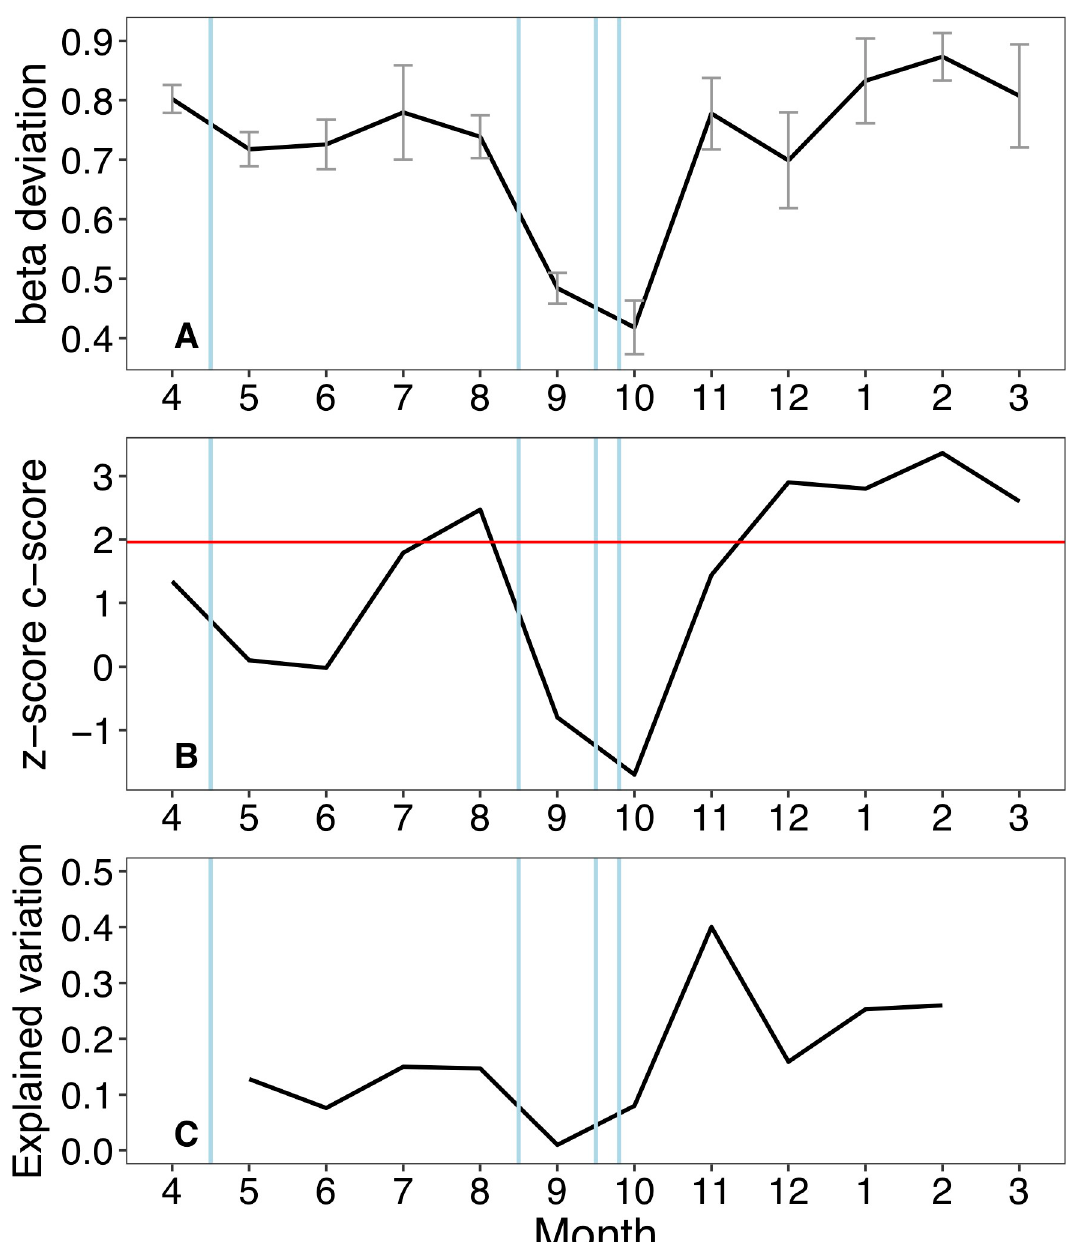
Fig 7. Inferring community assembly mechanisms. Temporal patterns in mean pairwise beta-deviation across waterbodies (A), species co-occurrence z-scores (B) and the proportion of variation in composition explained by local environmental parameters (C). Vertical blue lines indicate the occurrence of bankful flood events. The three indicators consistently showed that flooding weakened the signal of deterministic assembly processes. In (A), mean beta-deviation declined after each flood. In (B), months with stable hydrologic conditions were associated with non-random species co-occurrence patterns (above the red line at z-score = 1.96), which shifted to random patterns after flooding. In (C), flooding tended to decrease the match between local abiotic factors and species composition. Abiotic data for the first and last months were not